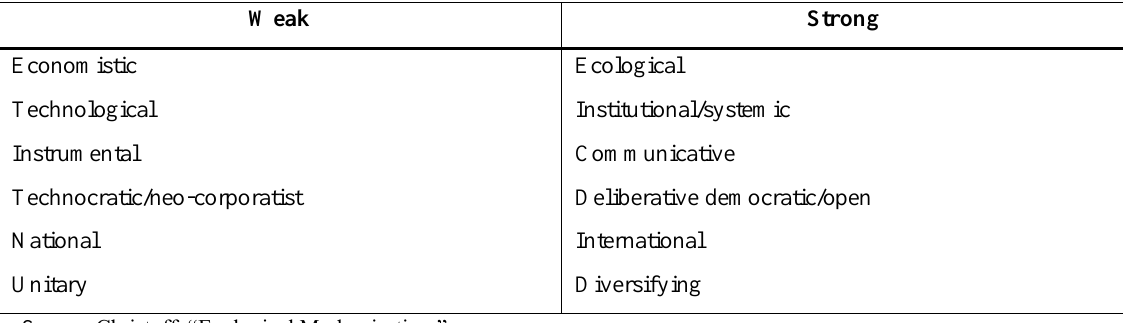
Table 1. Weak And Strong Ecologocial Modernisation Weak Strong Economistic Ecological Technological Instrumental